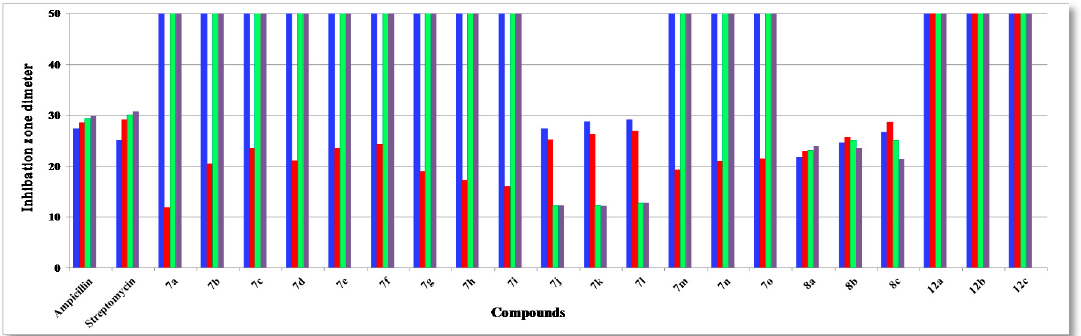
Figure 1. Antibacterial activity (Gram-positive) of the tested compounds compared to ampicillin and streptomycin: S. aureus (blue); S. epidermidis (red); B.subtilis (green) and B. pumilus (pale purple).